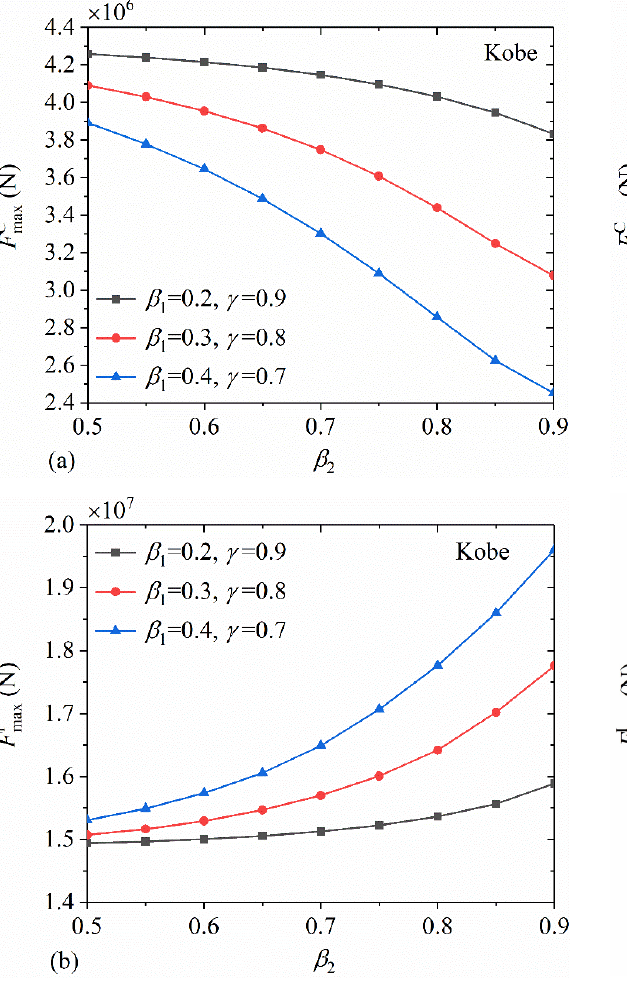
Figure 11. The maximum of the hydrodynamic shear for the upper baffle height β 2 : ( a ) the convective shear F C max ; ( b ) the impulsive shear F I max .